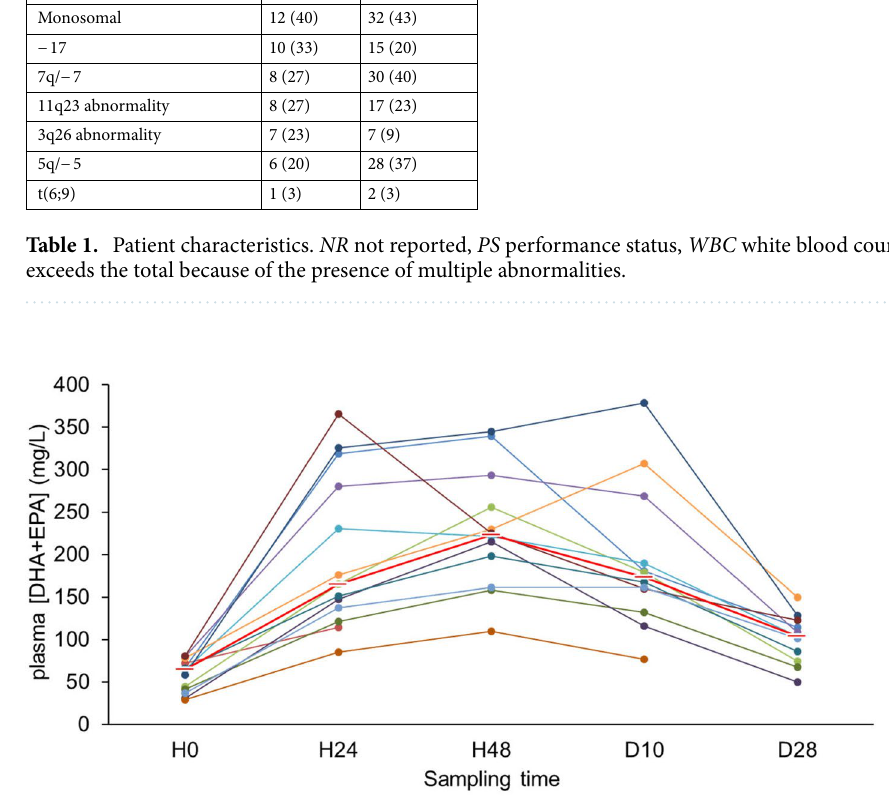
Figure 2. PUFA plasma pharmacokinetics. Plasma samples were drawn at baseline (H0), 24 and 48 h after the start of FO infusion, after the end of infusion (D10), and at disease evaluation (D28–D35). The PUFA composition of plasma was evaluated by gas chromatography. The sum of docosahexaenoic acid (DHA) and eicosapentaenoic (EPA) acid concentration is indicated for each individual patient (colored lines and dots). Means are indicated by a dash for each